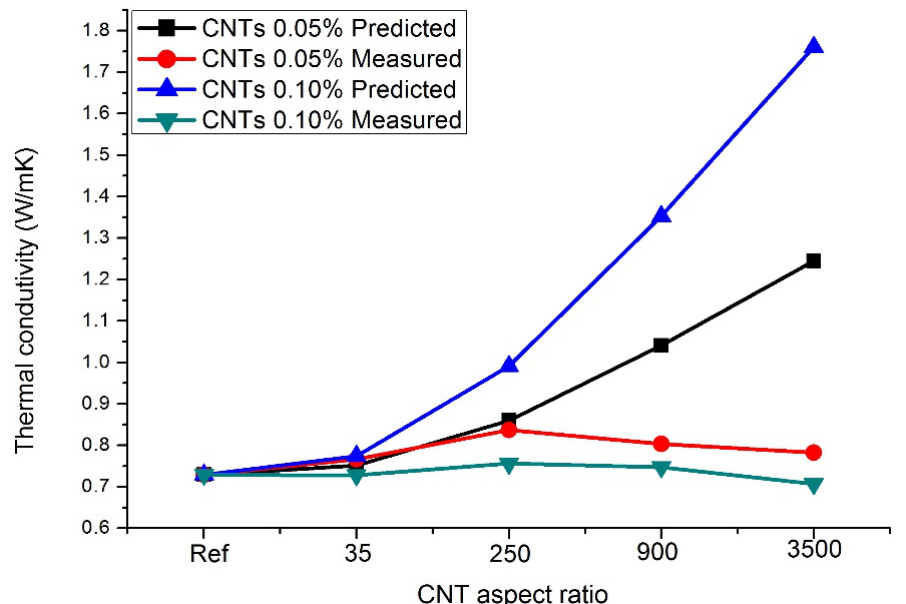
Figure 7. Predicted (Lewis-Nielsen model) and measured thermal conductivity of the CNT-reinforced cement pastes, for the different CNT aspect ratio and